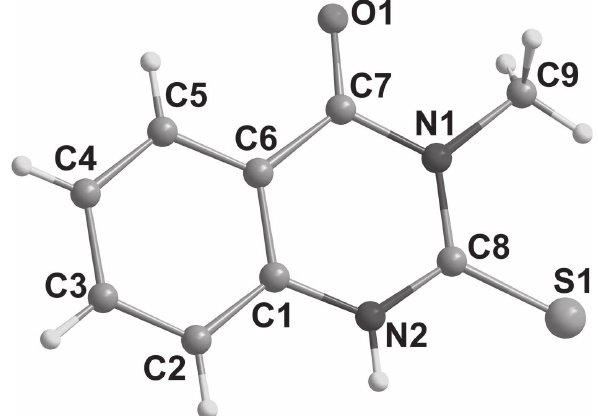
Table 2: Fractional atomic coordinates and isotropic or equivalent isotropic displacement parameters (Å 2